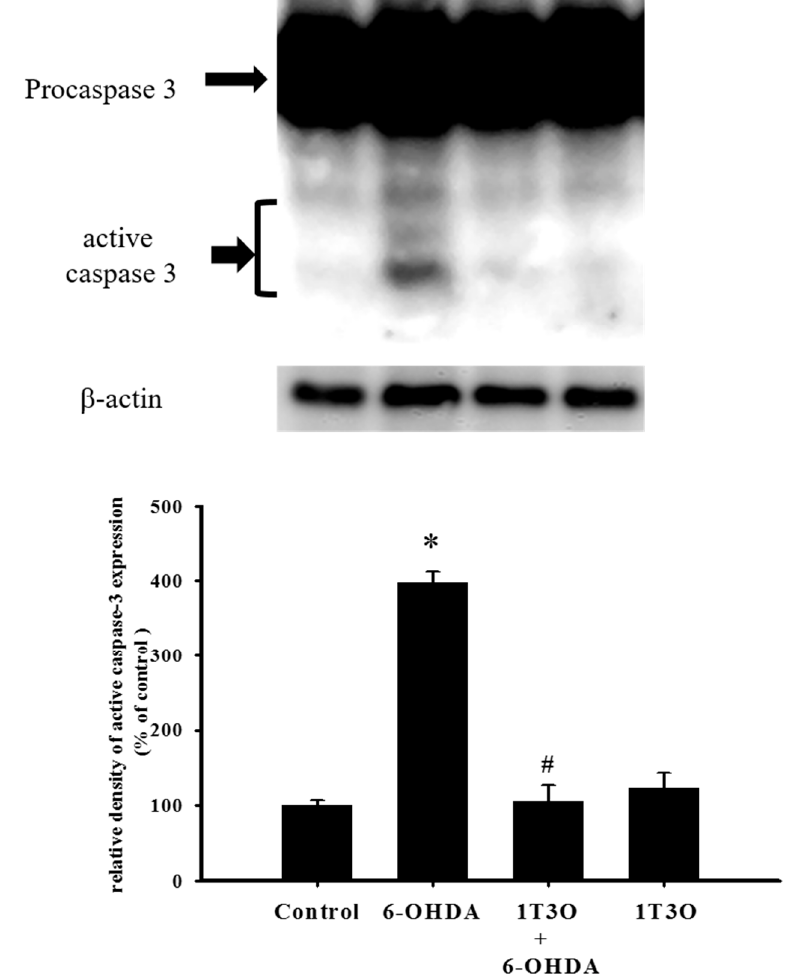
Figure 5. Effect of 1T3O on 6-OHDA-induced caspase-3 activation. Western blot was used to analyze the expression of caspase-3 and study the effect of 1T3O (1 μ M) on 6-OHDA-induced (20 μ M) caspase-3 activation. 1T3O significantly attenuated 6-OHDA induced caspase-3 activation. Data are represented by mean ± SEM. (* p < 0.05 vs. Control; # p < 0.05 vs. 6-OHDA group).